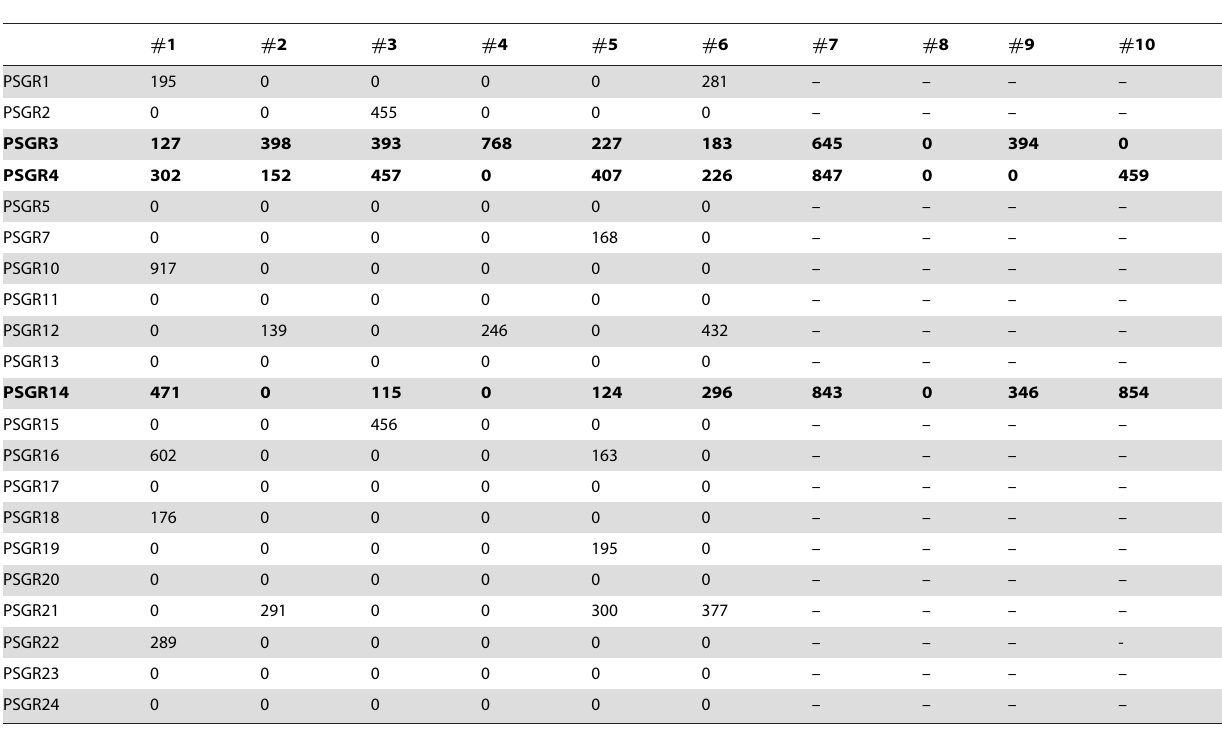
Table 2. Induction of peptide-specific T cells from the PBMCs of ten HLA-A2 + healthy subjects.